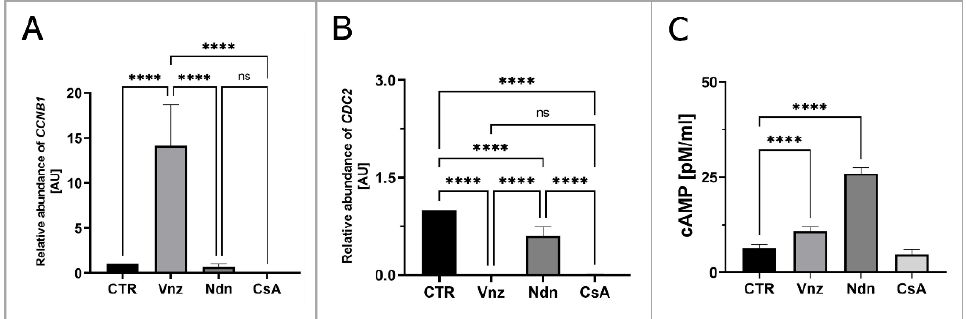
Figure 9. Analysis of the extent of meiosis/maturation progression in porcine COCs subjected to the IVM procedure using a 3D culture model (alginate capsules) in control cultures (CTR) or in experimental cultures: in the presence of vinclozolin (Vnz), nandrolone (Ndn) or cyclosporin A (CsA). ( A , B ): Quantitative profiles estimated for expression of CCNB1 and CDC2 genes, shown by RT-qPCR at the transcript level. The results are presented as mean values with n = 5 ± standard deviation (SD), and each “ n ” consisted of 50 COCs. ( C ): Analysis of intracytoplasmic cAMP concentration. Statistical analysis: homogeneity of variance—Brown–Forsythe test; normality of distribution—Bartlett’s test and one-way ANOVA followed by Dunnett’s post hoc test, **** p < 0.0001; ns—nonsignificant.